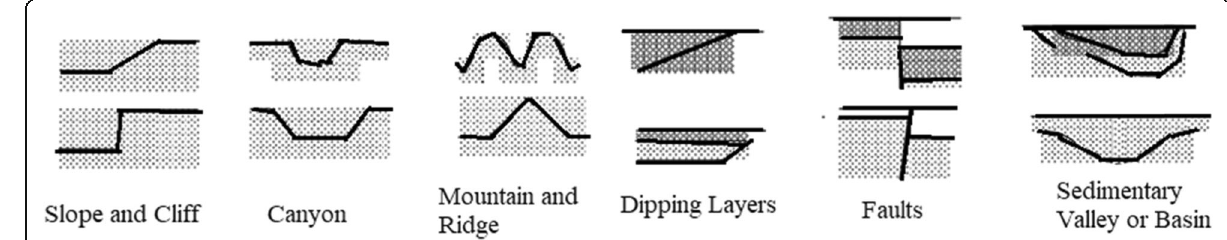
Fig. 3 Idealized examples of surface irregularities and subsurface irregularities (Naganoh et al.